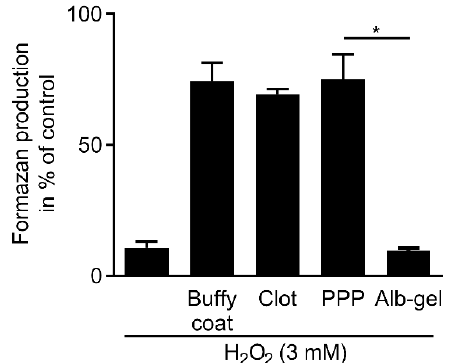
Figure 6. Buffy coat layer and blood clot but not the albumin gel neutralizes H 2 O 2 cytotoxicity. Gingival fibroblast cells were incubated with a buffy coat layer, blood clot, PPP, and Alb-gel (heated PPP) in the presence of 3 mM H 2 O 2 . MTT results showed that heating at 75 °C for 10 min can suppress catalase neutralizing activity while catalase remains active in all the other components. n = 3. Data represent the mean ± SD. * p < 0.05, by two-tailed Mann–Whitney test.